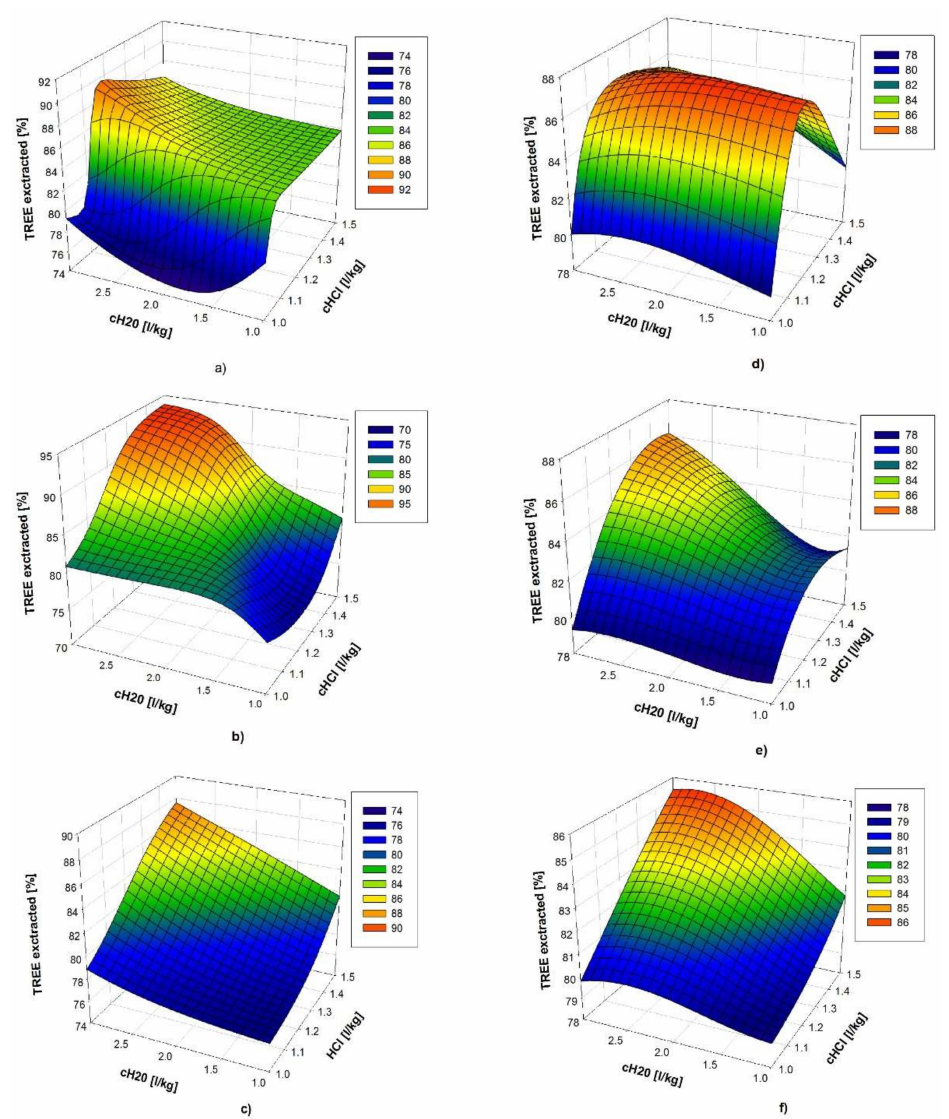
Figure 12. Examples of ANN models obtained during the leave-one-out cross validation (LOO CV) process: ( a ) ANN-4/3/2/1 model: excluded sample A4; ( b ) ANN-4/3/2/1 model: excluded sample A5; ( c ) ANN-4/3/2/1 model: excluded sample A10; ( d ) ANN-4/10/1 model: excluded sample A2; ( e ) ANN-4/10/1 model: excluded sample A10; and, ( f ) ANN-4/10/1 model: excluded sample